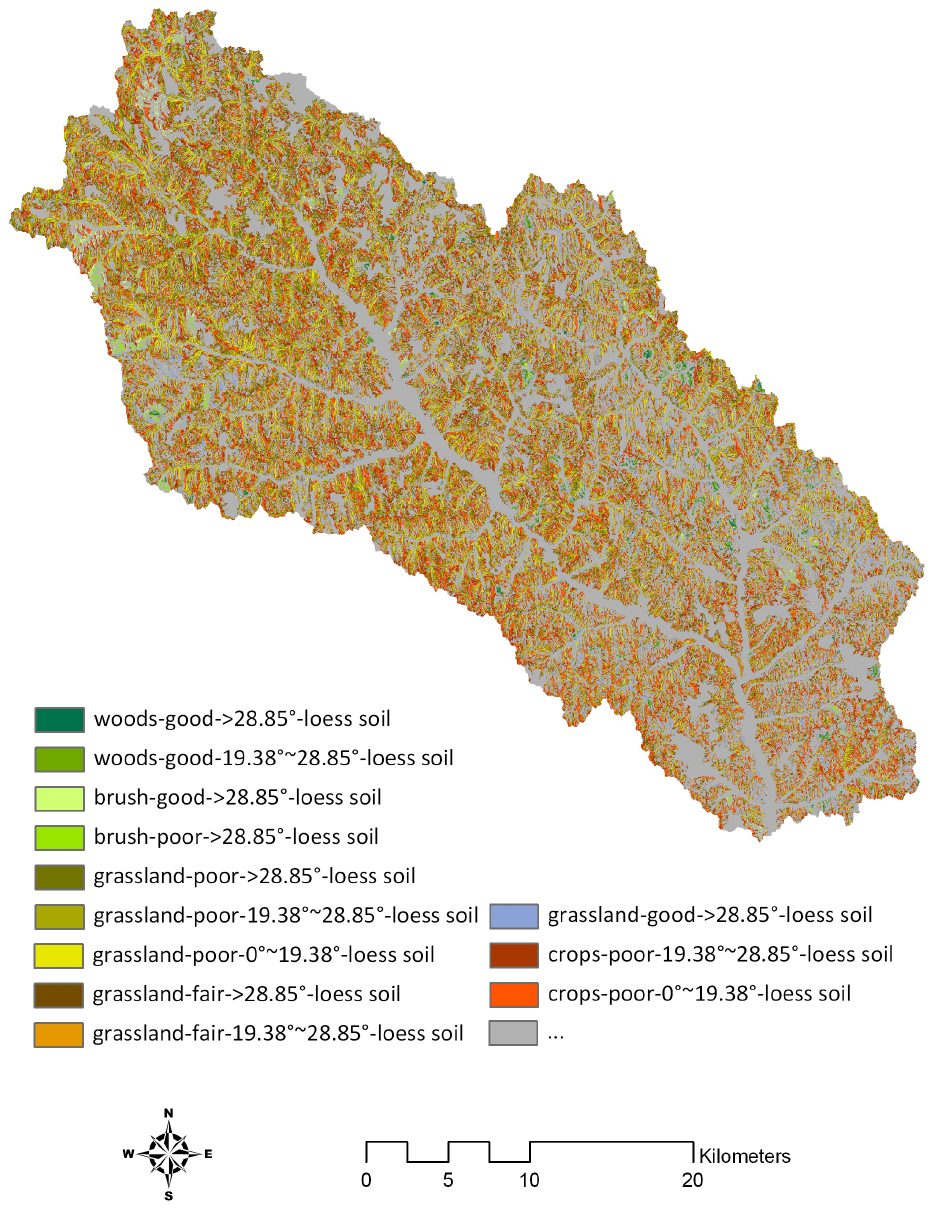
Fig. 2. Main land type units distribution within the Ansai